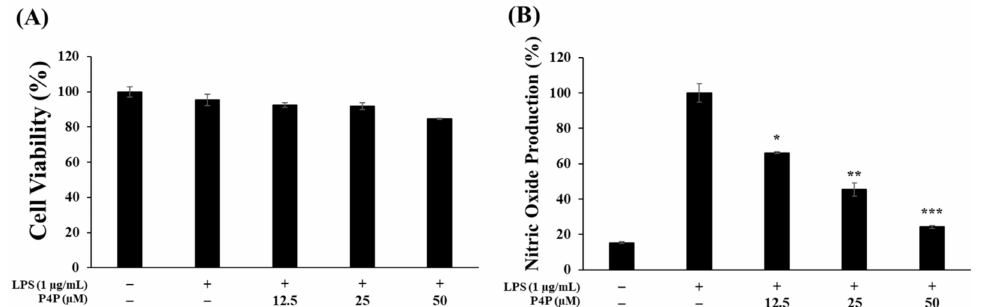
Figure 2. Activities of P4P on the toxicity and production of NO in RAW 264.7 cells induced by LPS. ( A ) Cell were treated with LPS (1 µ g/mL) in the presence/absence of P4P (0.01% DMSO) for 24 h. ( B ) The secreted NO level among samples was compared. The values of triplicate experiments are represented as the mean and standard deviation (SD). * p < 0.05, ** p < 0.01, and *** p < 0.005 versus LPS